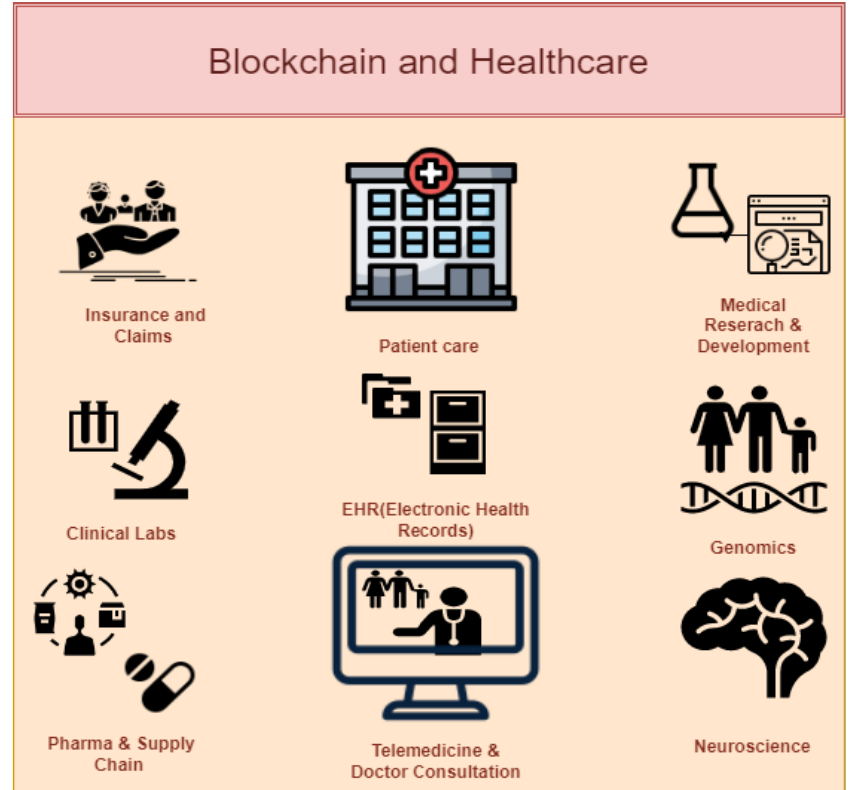
Figure 7 . Blockchain adoption in healthcare [16,68,71,74] . Figure 7. Blockchain adoption in healthcare